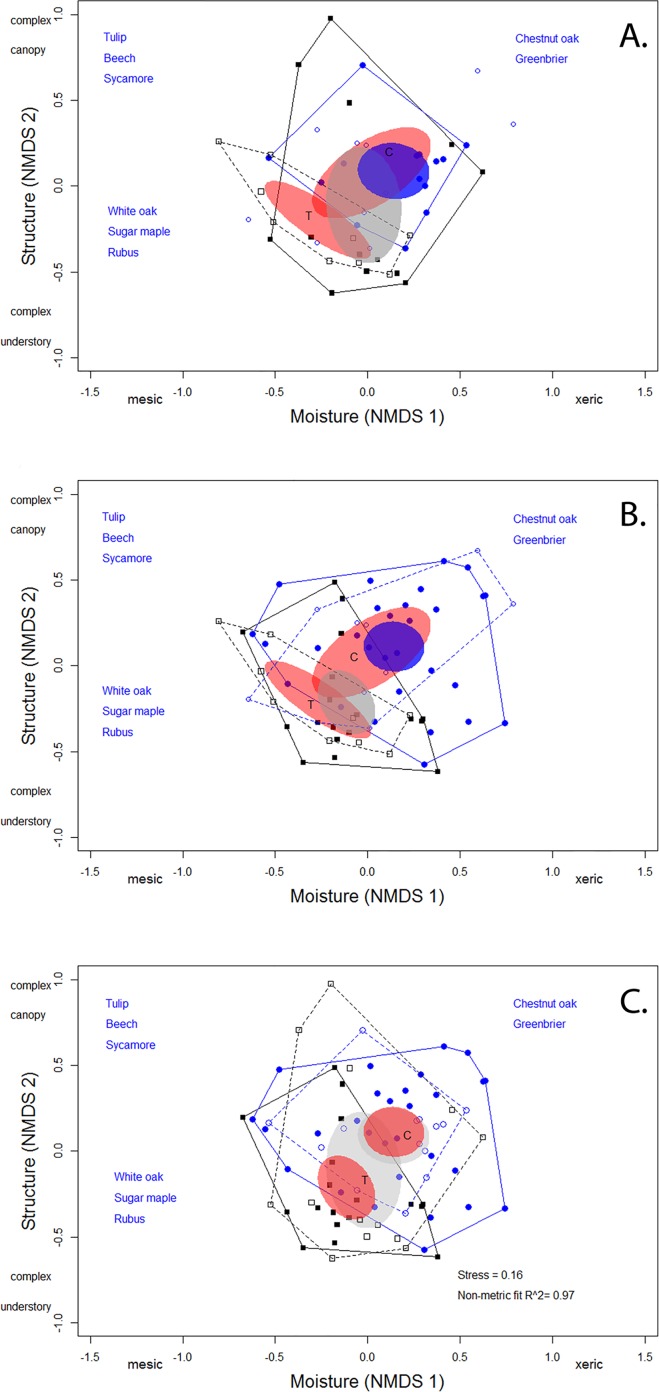
Comparison of habitat space between (A) male territories and random space, (B) female nest sites and random space, and (C) male territories and female nest sites. The position of the habitat plots in a space defined by the first two axes from the NMDS ordination in the unaltered (circles), and selective harvest (squares). Solid symbols represent territory plots (A) or nest plots (B) while open symbols represent random plots. Convex hulls define habitat space in each habitat (solid line = Territory; dashed lines = Random, blue = unaltered habitat and black = harvested habitat) and 95% confidence ellipses based on the standard deviation of the weighted distance from the group centroid (territories or nests in unaltered habitat = blue oval, territories or nests in harvested habitat = gray oval, random plots = red ovals). (C) Solid shapes represent nests sites and open shapes represent male territories. Convex hulls are drawn for female and male habitat space in each habitat (solid line = female nest; dashed lines = male territory) and 95% confidence ellipses based on the standard deviation of the weighted distance from the group centroid are indicated (female nest sites = red ovals; male territory = gray ovals).